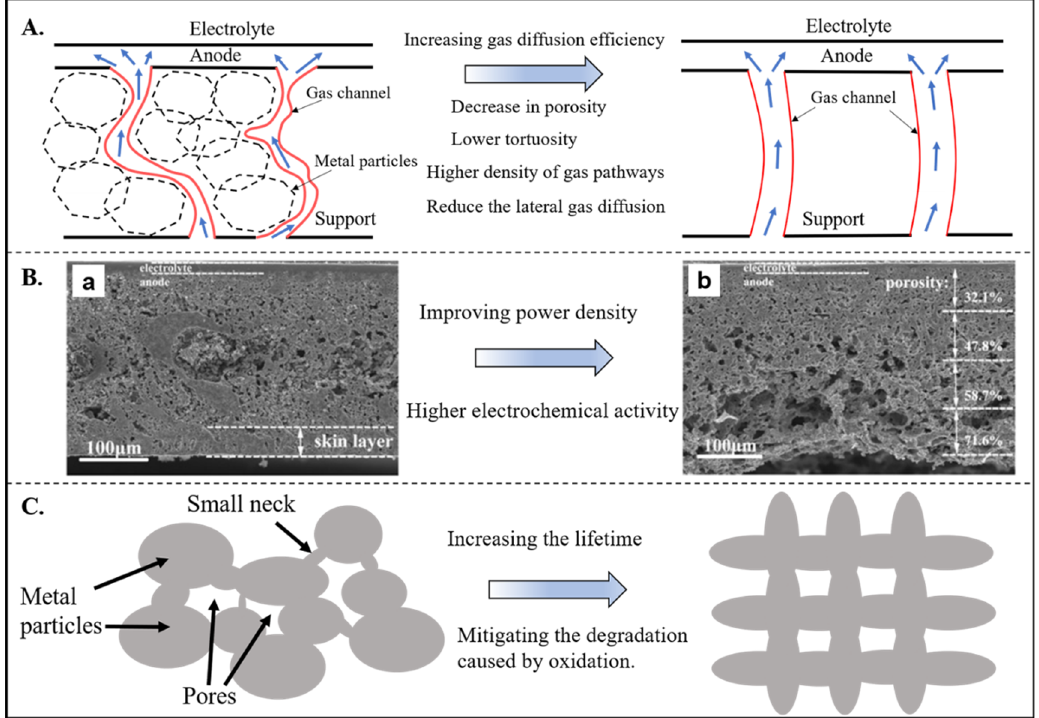
Figure 16. ( A ). Low-tortuosity gas channels have higher gas diffusion efficiency, adapted from Ref. [81]; ( B ). Gradient- porosity anodes facilitate electrochemical reactions, resulting in a higher power density, reproduced with permission from Ref. [152]; ( C ). Regular-shaped and -distributed pores avoid the formation of small necks, increasing the lifetime of